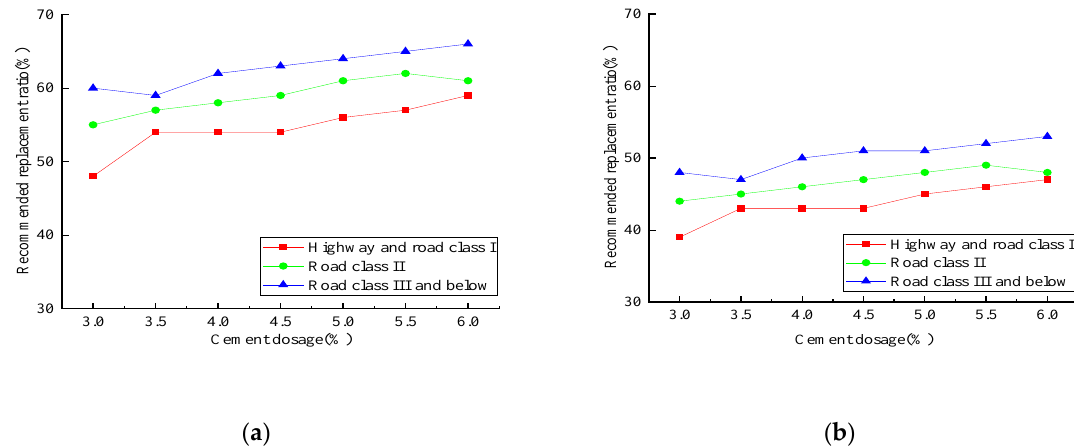
Figure 26. The maximum replacement ratio of reclaimed asphalt with respect to various cement dosage: ( a ) with the freeze–thaw effect; ( b ) without the freeze–thaw effect.